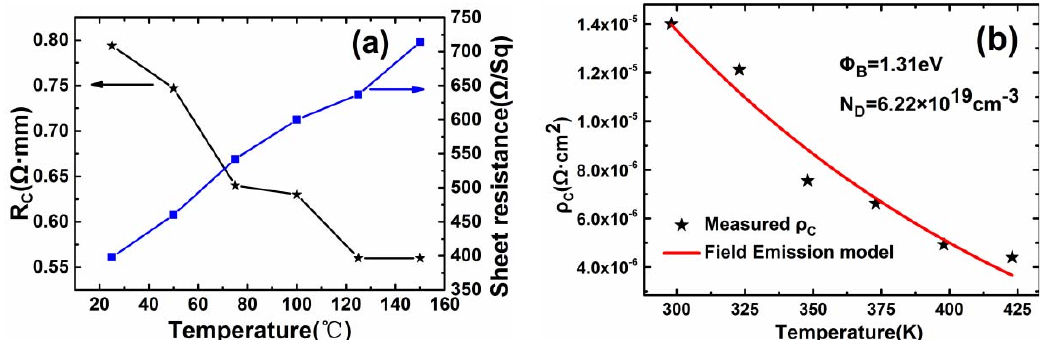
Figure 13. ( a ) Temperature − dependent characteristics of the R SH and R C of MWA − HEMT. ( b ) Measured (symbols) and modeled (lines) ρ C of MWA − HEMT as a function of temperature. Reprinted with permission from Ref. [89]. Copyright 2017, IEEE.